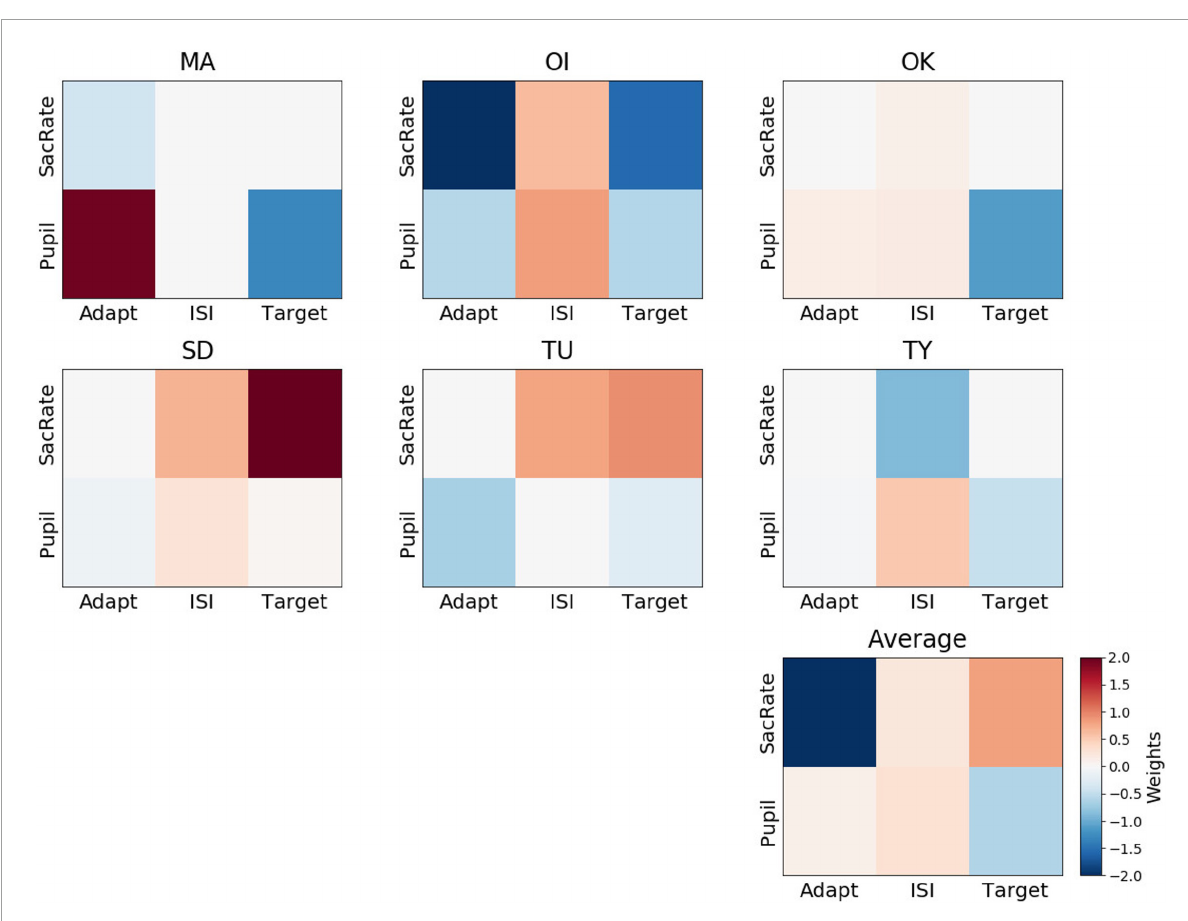
FIGURE6 Weights of the perceptual-confidence decoder. Representation of decoder weights from every participant attributed to the mean microsaccade rate (SacRate) and the mean pupil size (Pupil) during the adaptation (Adapt), inter-stimulus interval (ISI), and target (Target) periods, respectively. For visualization purposes, the color scale was bounded between – 2 and 2, but some weights were outside this